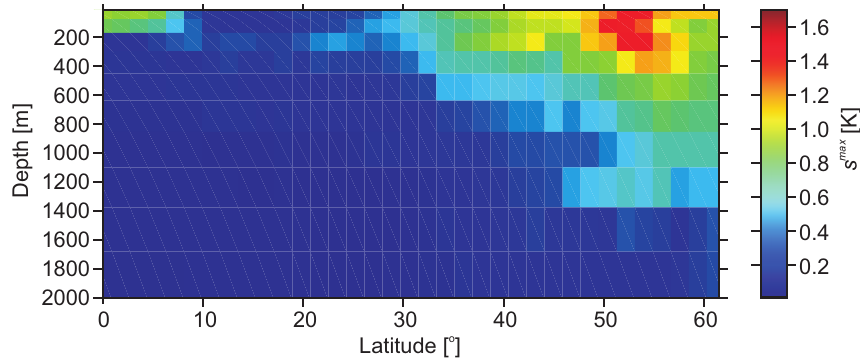
Fig. 5. Zonally averaged s max in a calibrated temperature proxy if the temperature variability attributable to the AMO is to be reconstructed for annually resolved data with a SNR >